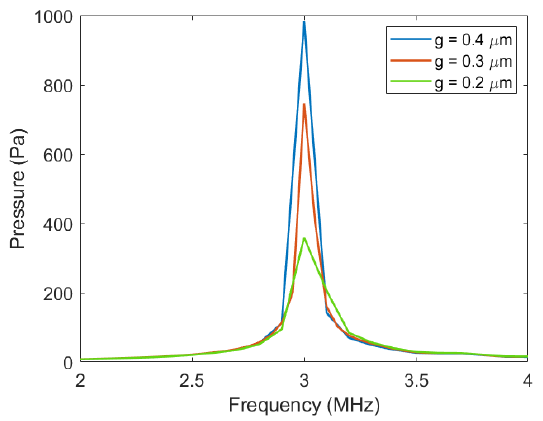
Figure 9. The sound pressure of different cavity heights.